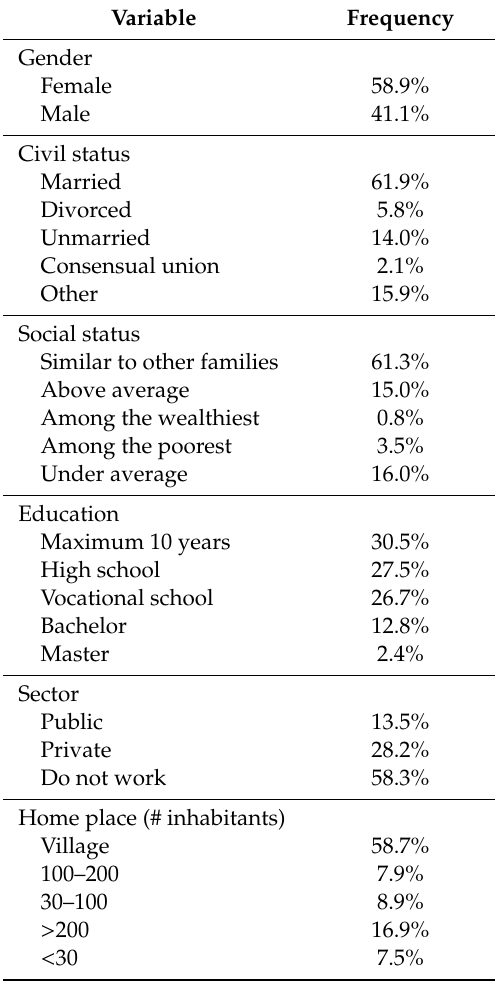
Table 2. Descriptive